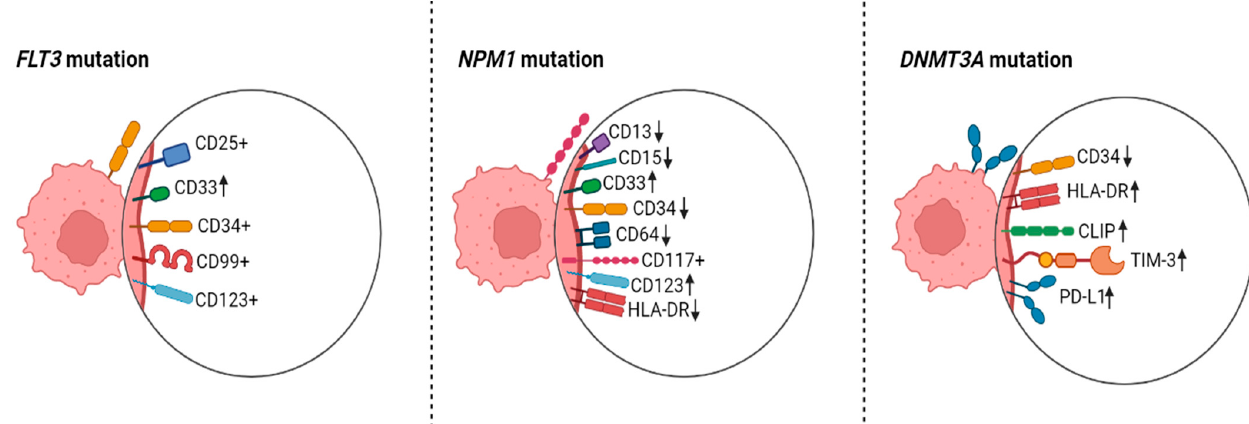
Figure 2. Commonly reported genetic mutations and associated immunophenotypic characteristics in acute myeloid leukemia (AML) neoplastic clones. CD: cluster of di ff erentiation; DNMT3A: DNA methyltransferase 3 alpha; FLT3: fms-related receptor tyrosine kinase; HLA-DR: major histocom- patibility complex, class II, DR; NPM1: nucleophosmin 1; PD-L1: programmed cell death 1 ligand 1; TIM-3: T-cell immunoglobulin mucin family member 3. Created with